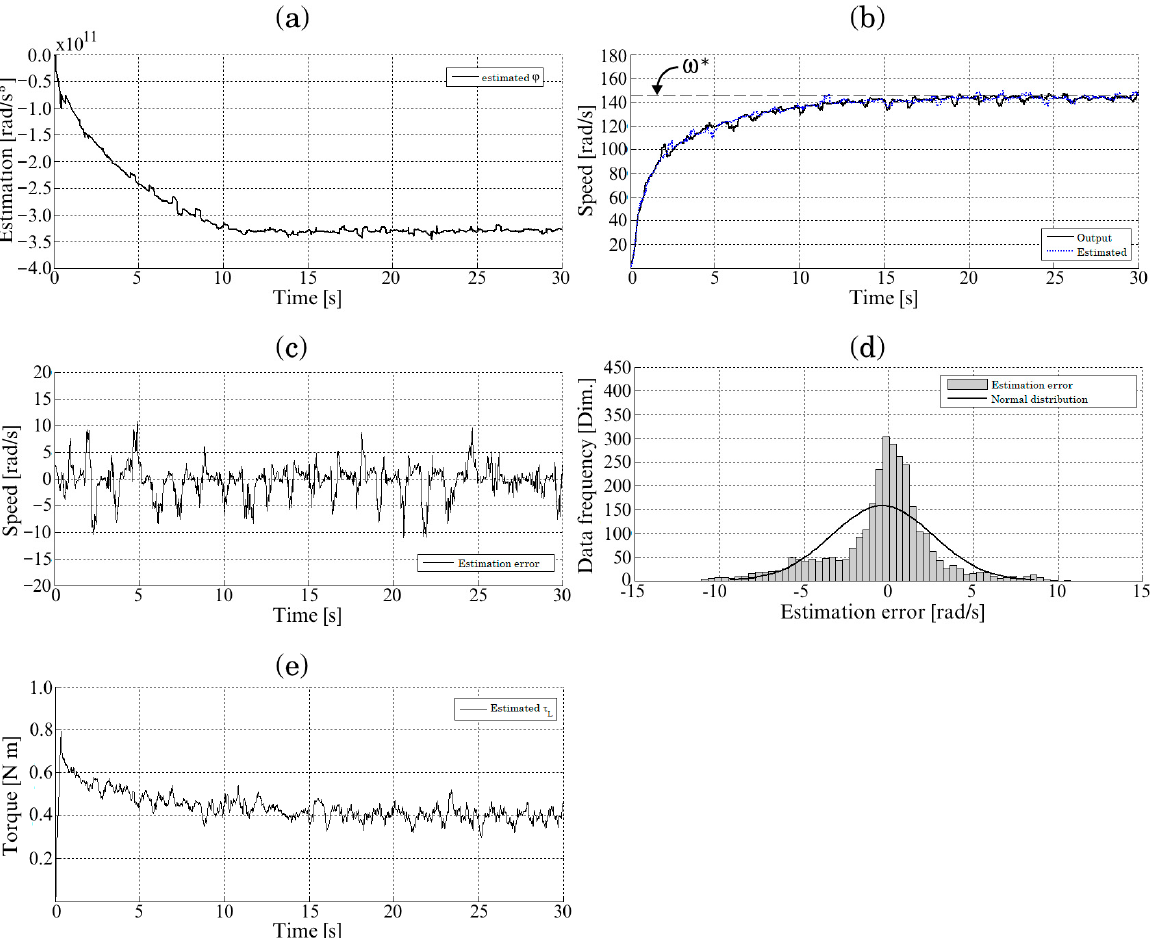
Table 5. Summary statistics of GPI observer that estimate the disturbances.